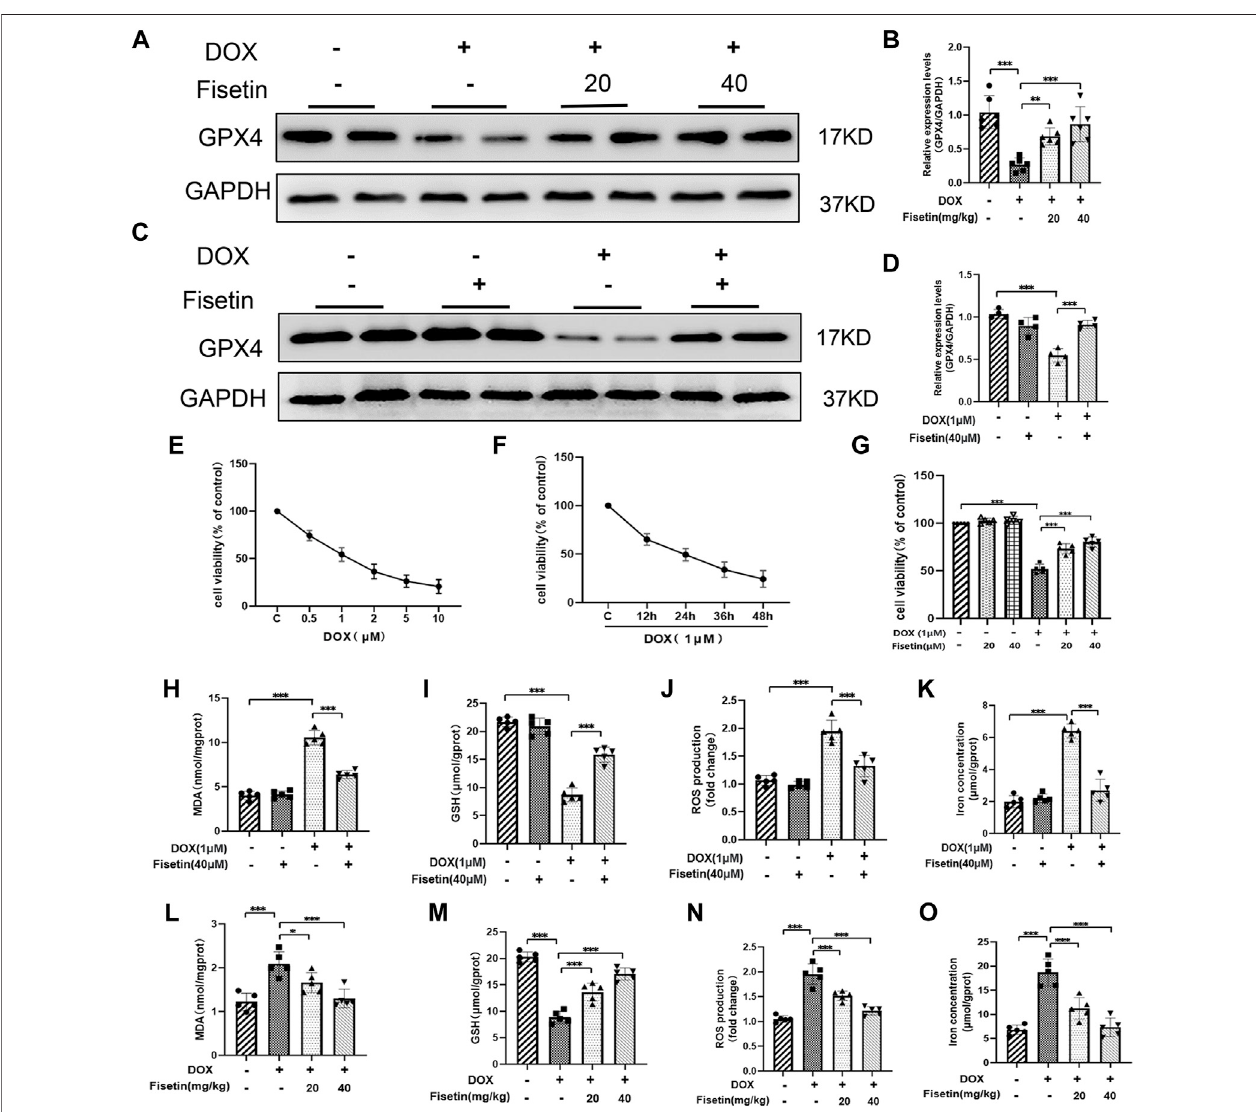
FIGURE3| FisetinattenuatesDOX-inducedferroptosis. (A) WesternblotresultsofGPX4levelsinrathearttissues.GAPDHwasusedasnormalization control. (B) Quanti fi cation of the GPX4 level from Western blot (A) . (C – D) Western blot results of GPX4 levels in H9c2 cells; the expression was quanti fi ed by ImageJ analysis. (E) ResultsoftheCCK-8assay.H9c2cellsexposedtodifferentconcentrationsofDOXfor24 h. (F) CellsurvivalrateofH9c2cellsexposedto1 µMDOXusingCCK-8assay. (G) Cell survival rate of co-administration of DOX + fi setin (20 and 40 µM) in H9C2 cells. (H – K) MDA, GSH, ROS, and iron concentration levels in cells in different groups. (L – O) MDA, GSH, ROS, and iron concentration levels in heart tissues. The values are presented as mean ± SD. * p < 0.05; ** p < 0.01; *** p < 0.001; NS, no signi fi cance; GPX4, glutathione peroxidase 4; GSH, glutathione; ROS, reactive oxygen species; MDA, malondialdehyde; CCK-8, Cell Counting Kit-8.